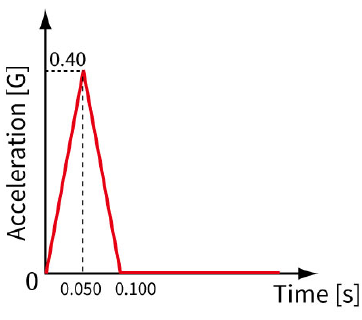
Figure 1. Computational model.